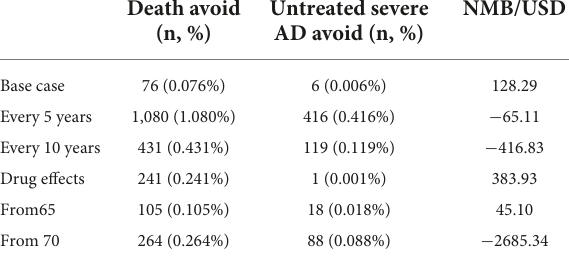
TABLE 5 Secondary outcomes of the scenario